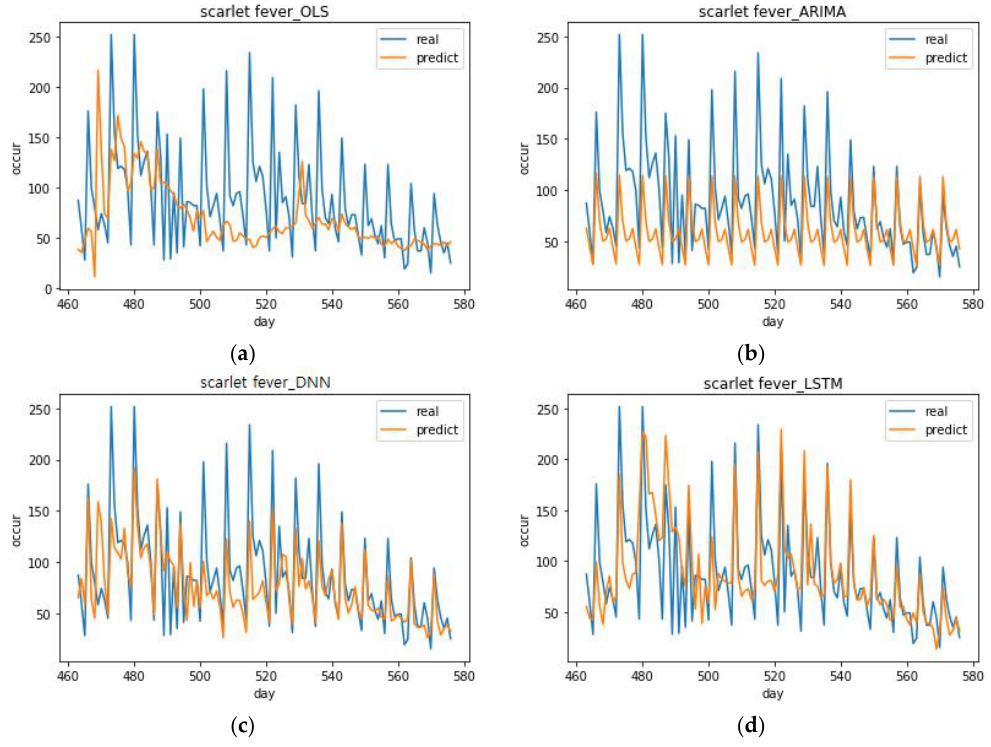
Figure 8. Top performing scarlet fever predictions for each analysis method. ( a ) Prediction graph of OLS model in scarlet fever, ( b ) Prediction graph of ARIMA model in scarlet fever, ( c ) Prediction graph of DNN (1, 1, 2) model with the best performance in scarlet fever, ( d ) Prediction graph of LSTM (4, 1, 1) model with the best performance in scarlet fever.